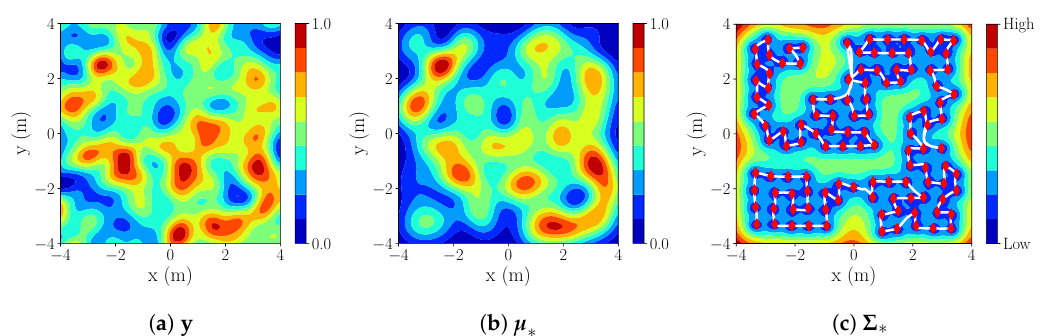
Figure 9. Environment for scenario S2.